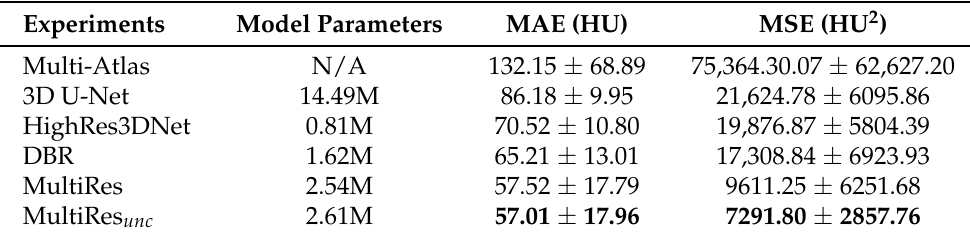
Table 2. MAE and MSE across all experiments on the brain dataset including number of trainable variables. Bolded entries denote best model ( p -value <